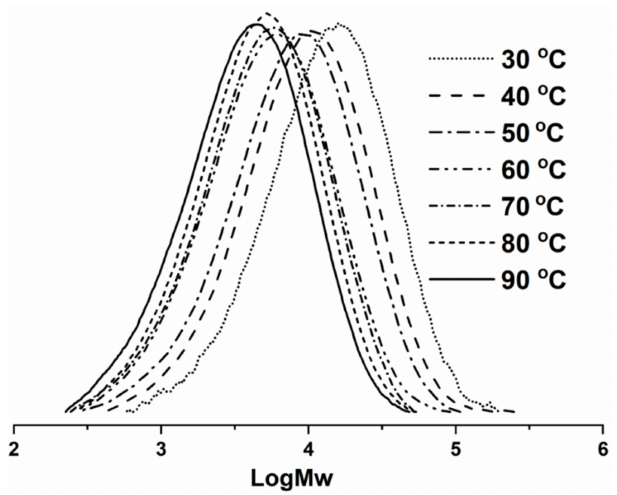
Figure 7. GPC curves showing log M w of the polyethylenes produced using Co1/ MMAO as a function of the reaction temperature (runs 1–7, Table 3).